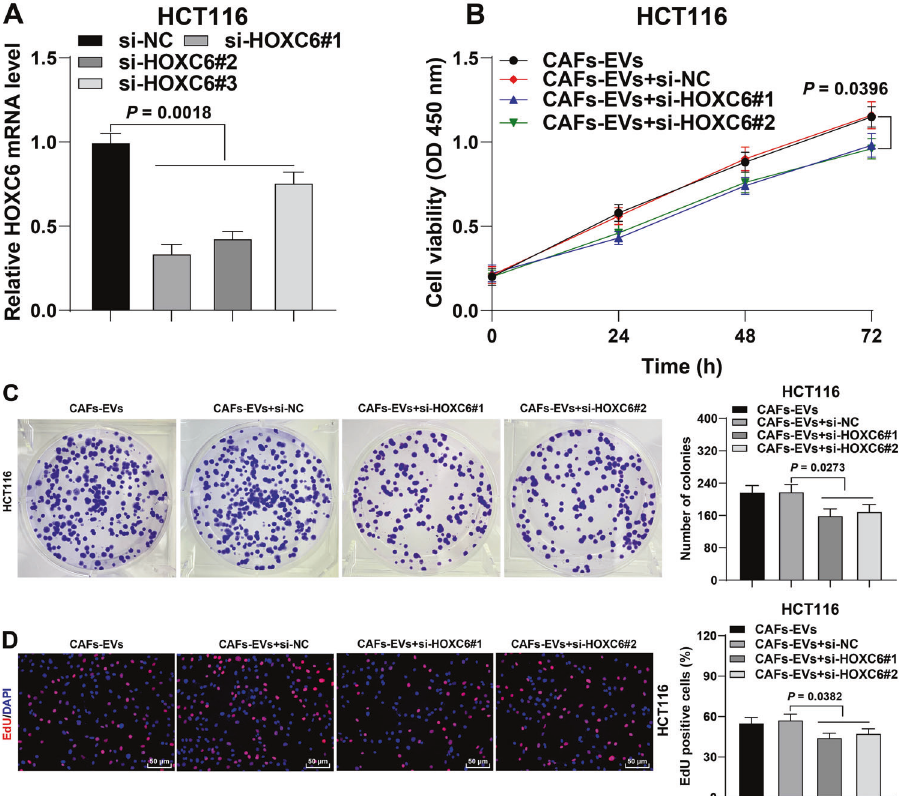
Fig. 7 HOXC6 silencing depressed the promoting effect of CAFs-EVs on CRC cell proliferation. Three HOXC6 siRNAs (si-HOXC6) were transfected into HCT116 cells respectively, with NC siRNA (si-NC) as negative control. Then, si-HOXC6-transfected HCT116 cells were treated with CAFs-EVs. A HOXC6 mRNA expression in HCT116 cells was determined using RT-qPCR. B – D The cell proliferation ability was measured using CCK-8 assay ( B ), colony formation assay ( C ), and EdU staining ( D ). The cell experiment was repeated three times independently. Data are presented as mean ± standard deviation. Data in A / C , D were analyzed using one-way ANOVA, and data in B were analyzed using two-way ANOVA, followed by Tukey ’ s multiple comparisons